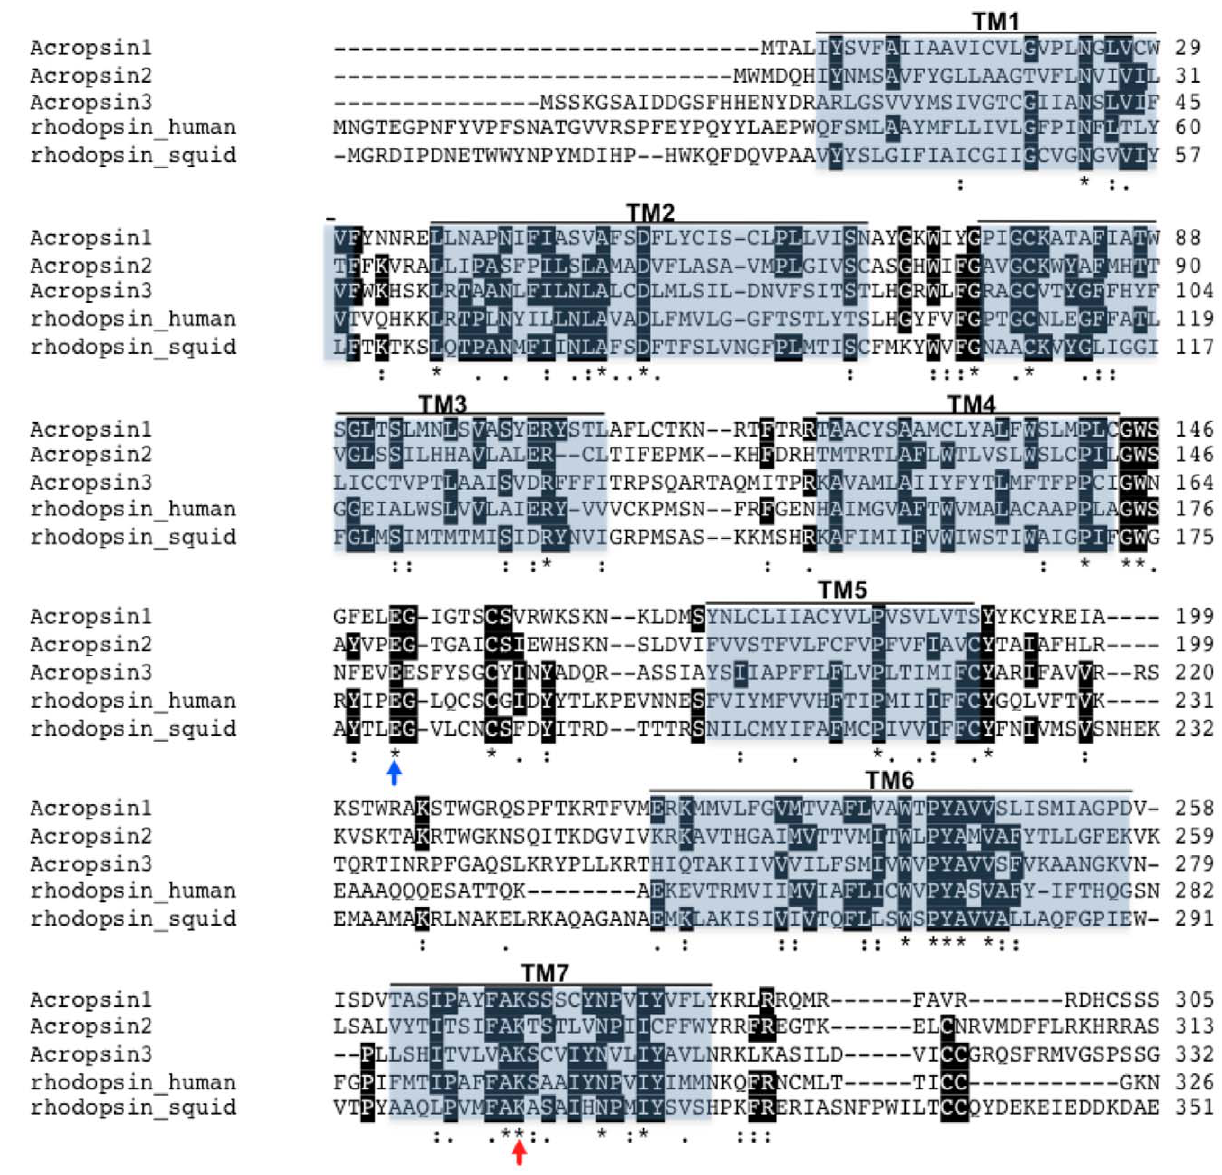
Figure 1. Partial alignment of acropsins 1–3 with human and squid rhodopsins. Amino acid sequences of acropsins 1–3 were aligned with Homo sapiens (NP_000530) and Loligo forbesi (CAA40108) rhodopsins using ClustalW. Shaded regions indicate transmembrane domains (TM1-TM7) and are based on positions in H. sapiens rhodopsin. The red arrow denotes the retinal-binding lysine (K296 in human rhodopsin); blue arrow, the conserved glutamate (E181 in human rhodopsin) that serves as the counterion stabilizing the Schiff base linkage of retinal. Black highlighting indicates identity with the consensus. NOTE: The total length of acropsin 3 is 666 amino acids, but the c-terminus bears no resemblance to other known